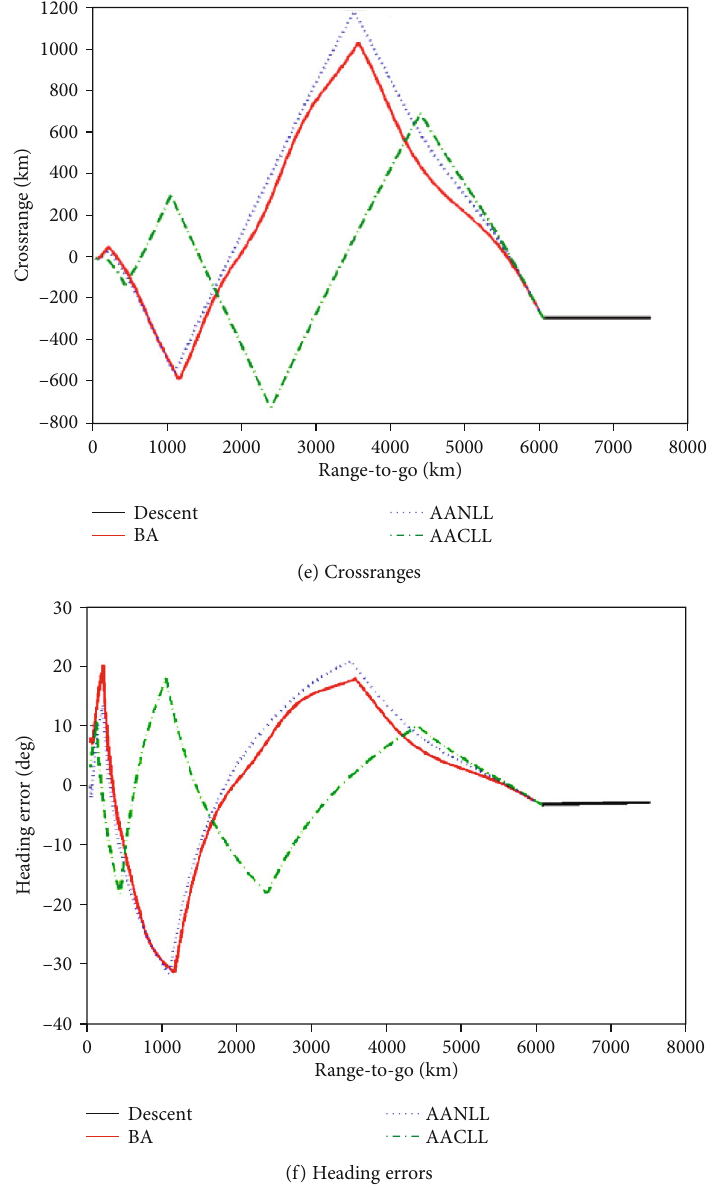
Figure 2: Trajectory comparison of the three cases for mission